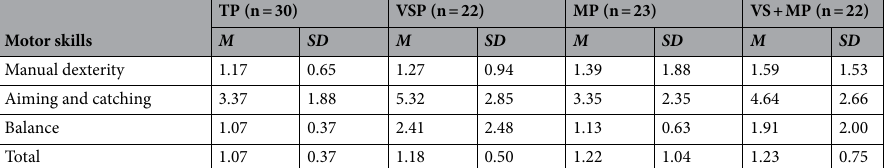
Table 2. Means and standard deviations for ASD children’s scaled scores on the MABC-2 for each protocol. TP traditional protocol, VSP visual support protocol, MP motivation protocol, VS + MP visual support plus motivation